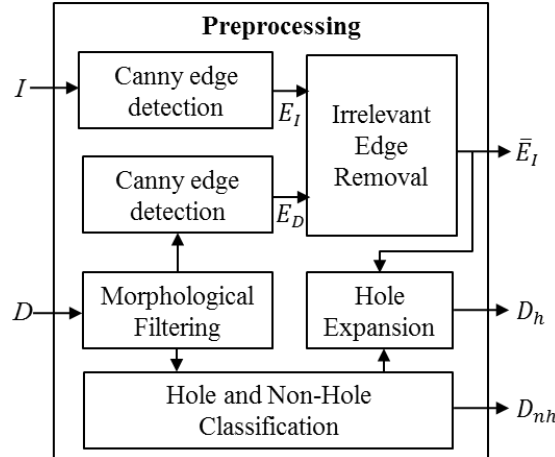
Figure 3. Edge detection and hole expansion in the preprocessing block of Figure